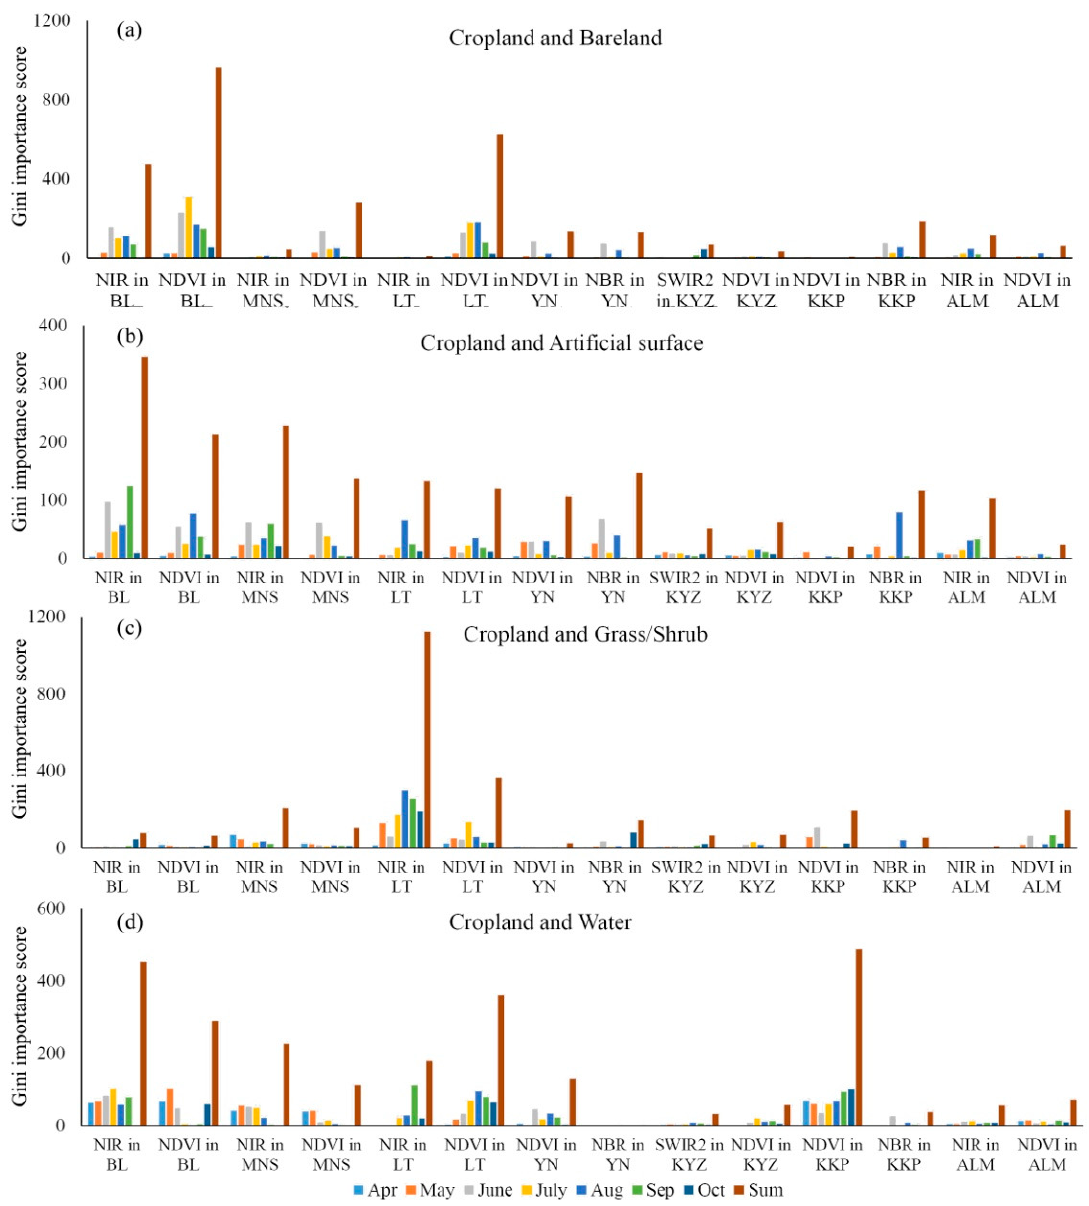
Figure 8. Gini importance scores of two optimal features for each study site.